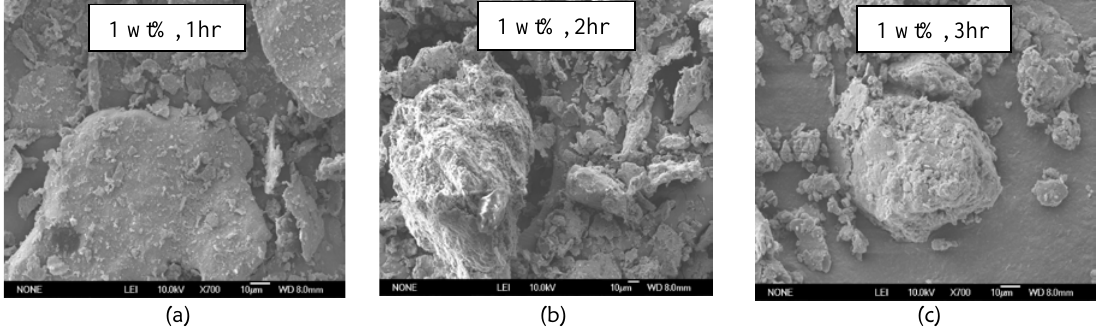
Figure 2: Microstructure of 1 wt% of CNT at 250 rpm for different ball milling time.